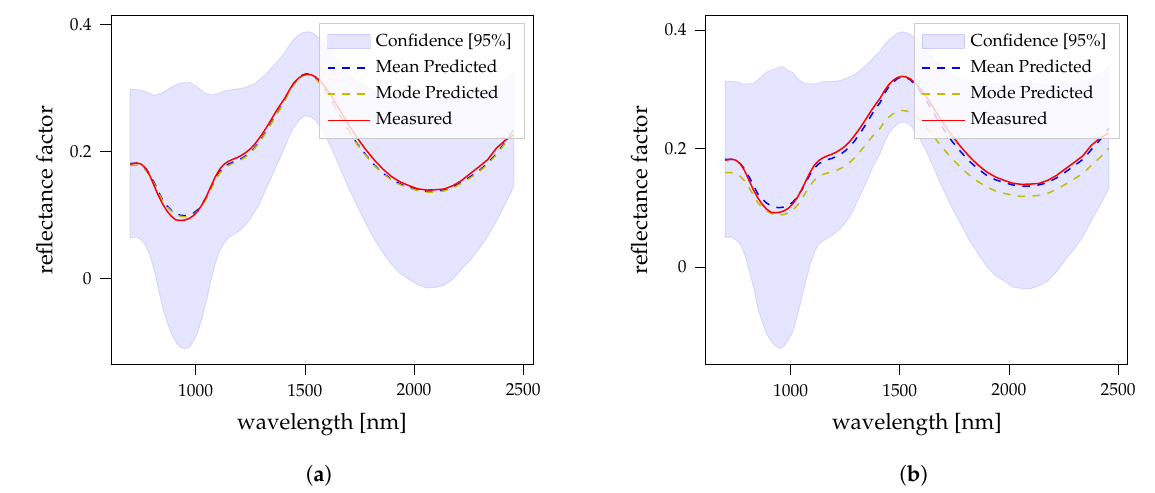
Figure 18. Confidence for mix 10 of the fresh laboratory mixtures. The prediction of the 0.9 µ m absorption is slightly less certain for the version with a prior on TiO 2 abundance. Mean predicted spectra are almost identical, even though the weights are quite different. For the version without an elemental prior the sampled σ is 0.011 and 0.012 for the version with a TiO 2 prior. ( a ) Without prior; ( b ) TiO 2 prior.